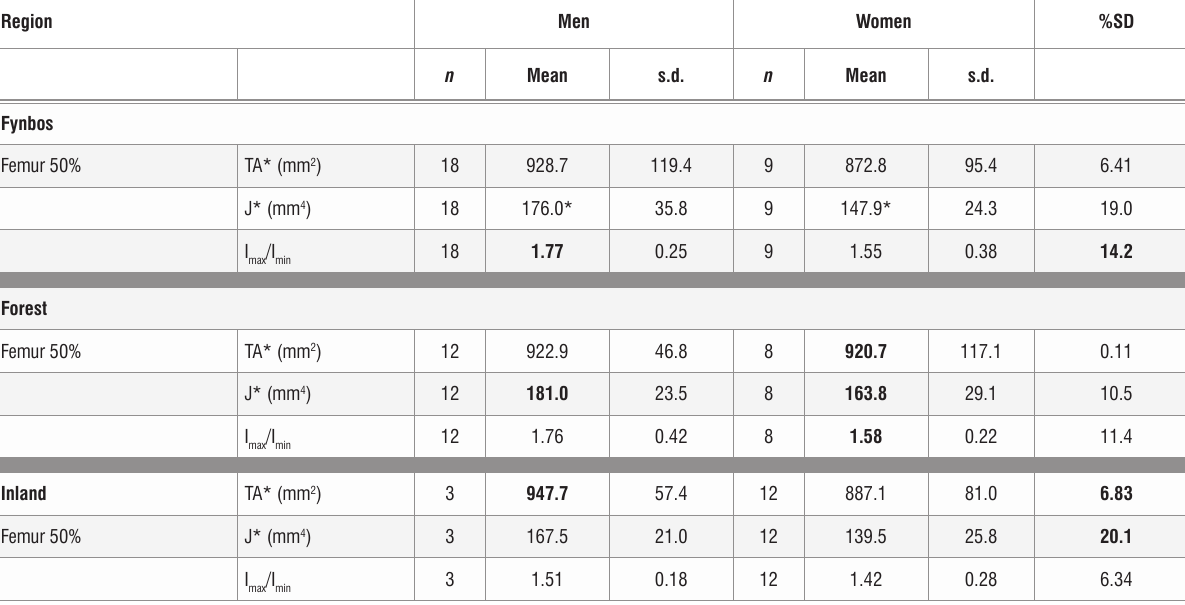
Comparison of femur total subperiosteal area (TA*), torsional strength (J*), maximum versus minimum bending strengths (I sexual dimorphism (%SD) for lower Orange River Valley (inland), forest and fynbos samples Region